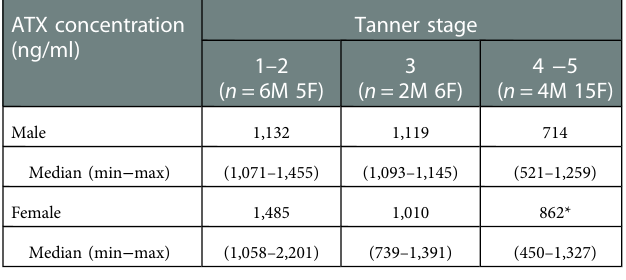
TABLE 2 Normal values of ATX according to sex and pubertal